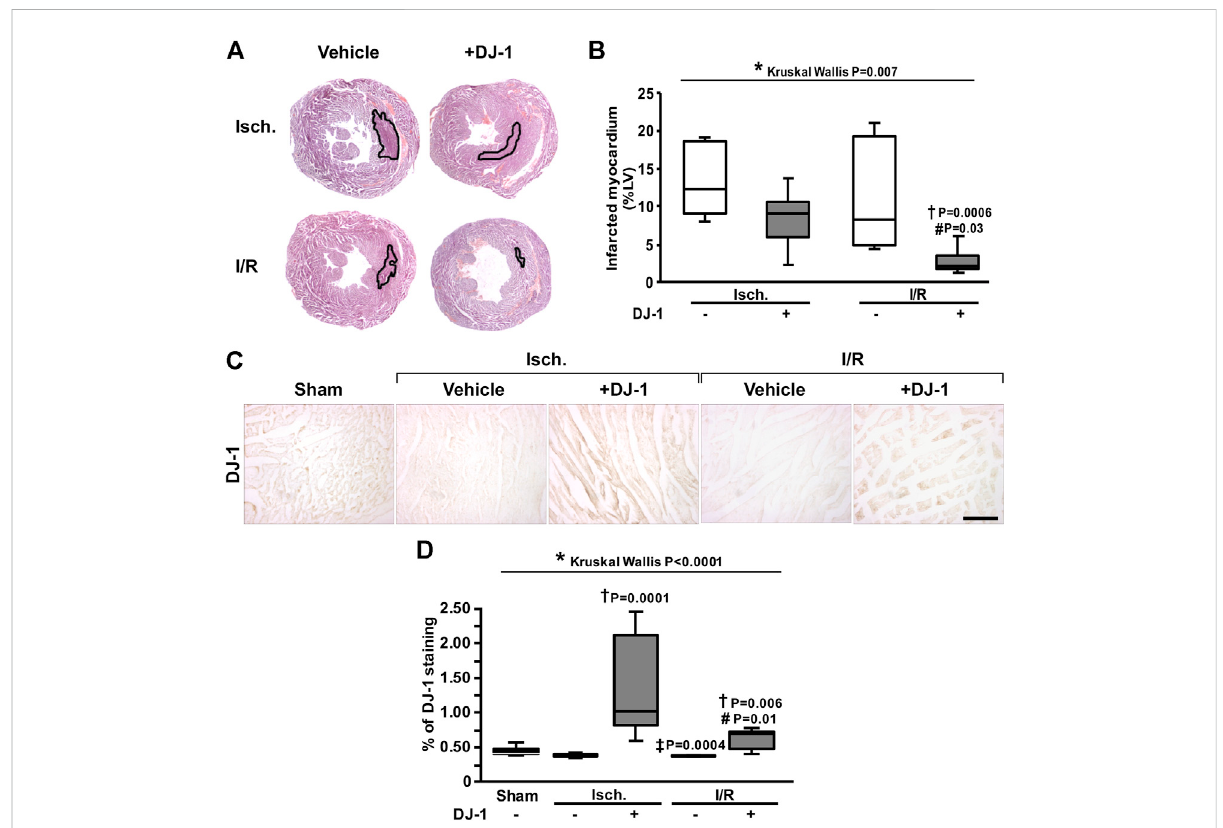
Effects of systemic DJ-1 administration on infarct size in a mouse model of MI. (A) . Representative images of infarcted heart sections. Infarct area is outlined in black. (B) . Infarct size quanti fi cation after ischemia and ischemia/reperfusion, in the presence and the absence of a systemic administrationofDJ-1.Infarctmeasuresareexpressedaspercentage ofleftventriclearea. (C) .Representative immunohistochemicalacquisitionsof DJ-1 in the myocardium after ischemia and ischemia/reperfusion, in the presence and the absence of a systemic administration of DJ-1. A sham-operated group was included as baseline. (D) . DJ-1 myocardium content quanti fi cation across groups. Scale bar: 100 µm; * p < 0.05, Kruskal- Wallis; † p < 0.05 vs. ischemia without DJ-1, ‡ p < 0.05 vs. ischemia + DJ-1, # p < 0.05 vs. I/R without DJ-1, Dunn ’ s test. LV, Left Ventricle; Isch., Ischemia; I/R,